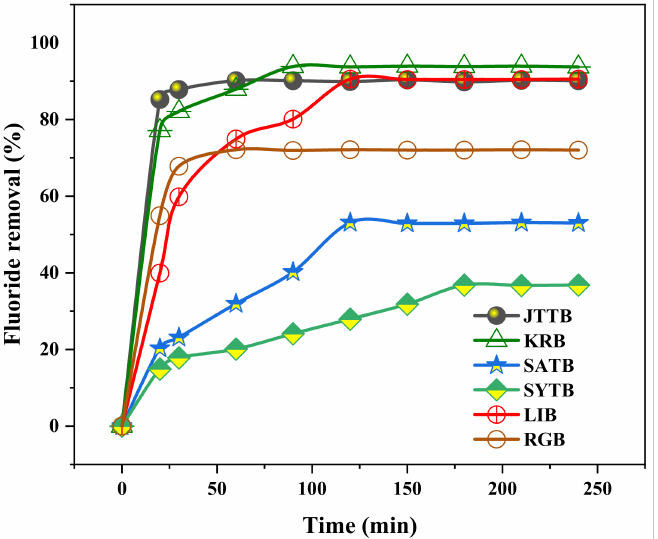
Figure 5. Fluoride removal with contact time. Data obtained from references